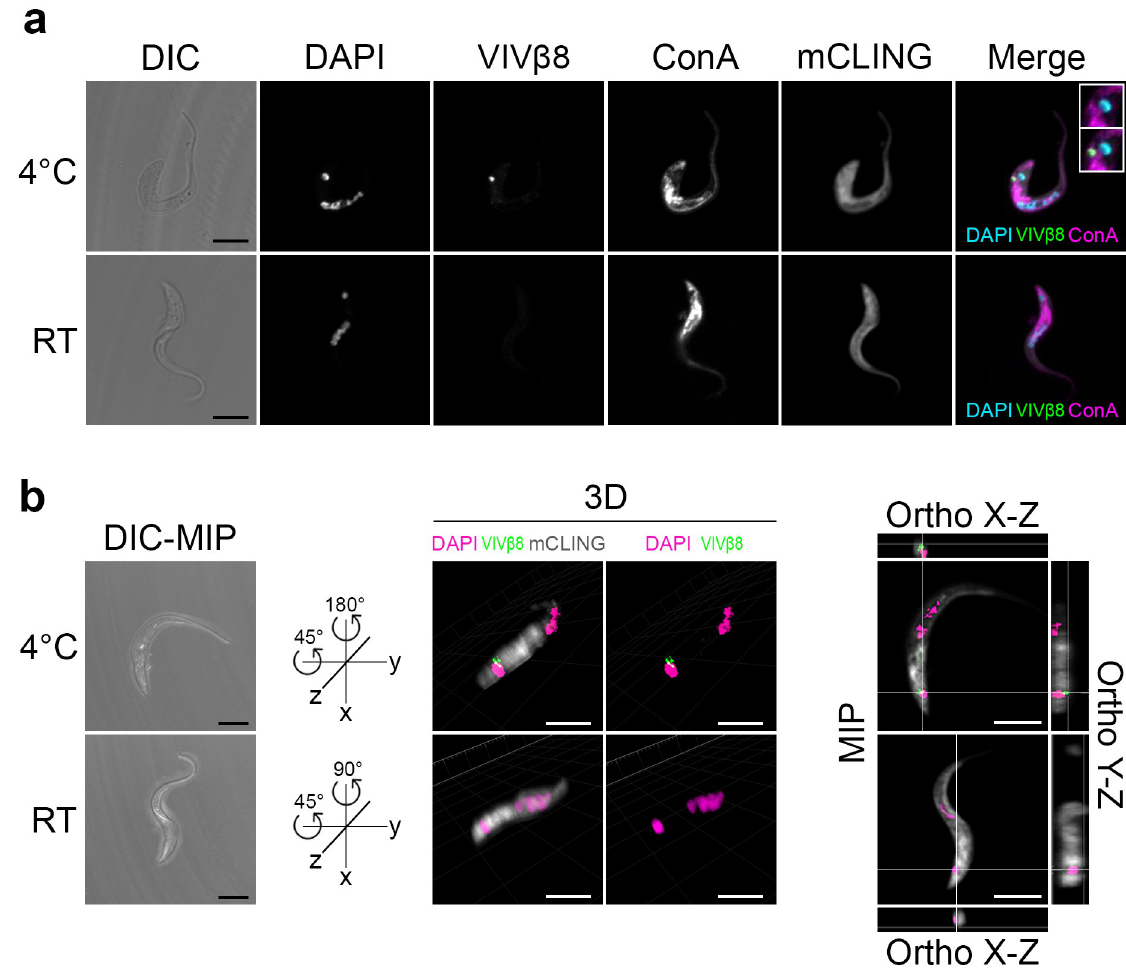
Fig 7. Live immunostaining of VIV β 8 antigen in native cells. (A) Live T . vivax bloodstream forms were immunostained either at 4˚C to halt the secretory pathway or at room temperature (RT) to preserve it active. DIC; DAPI; VIV β 8 (secondary AF555-conjugated antibody); concanavalin A (ConA) FITC-conjugated lectin ER counterstain; mCLING unspecific staining and merged channels. Close-ups in merge channel show the flagellar pocket (end of ER, next to kDNA) without (top) or with (bottom) VIV β 8 green signal. Scale bars; 5 μ m. (B) 3D localization of VIV β 8 in live cells. Representative cells immunostained at 4˚C or RT were 3D reconstructed in DIC-maximum intensity projection (DIC-MIP, left) and rotated to equivalent positions in the space to display VIV β 8 next to the kDNA only in 4˚C cells (middle). MIP fluorescence projections (right) and orthogonal views. Scale bars; 5 μ